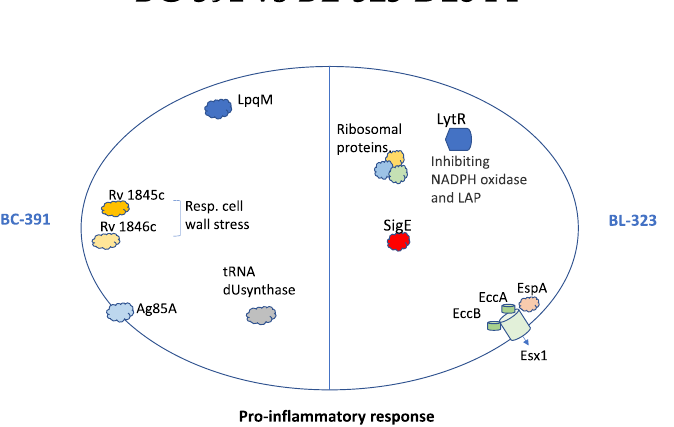
Figure 8. Schematic model describing key genes that lead to the pro-inflammatory response in both strains.